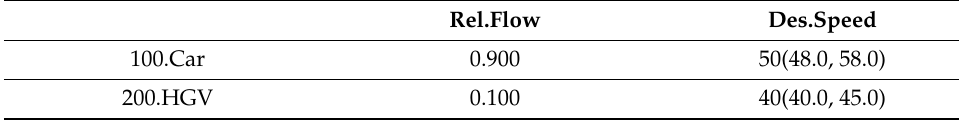
Table 3. The traffic composition of VISSIM.